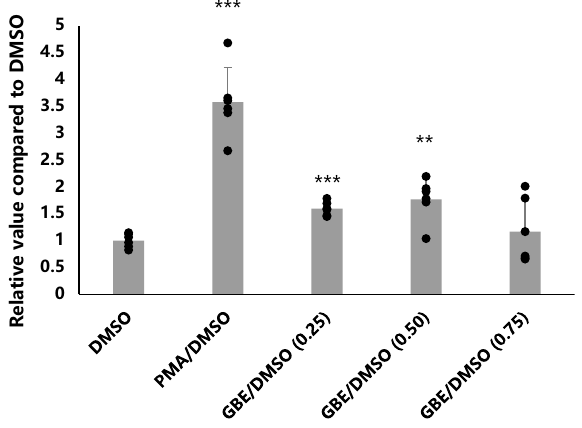
Figure 1. Effects of various GBEs concentrations on EGR-1 activation in a luciferase assay. GBEs were tested at three different doses, and both 0.25 mg/ml and 0.5 mg/ml concentrations of GBEs showed a statistically significant increase in EGR-1 activity in a luciferase assay (n = 6). ** p < 0.01, *** p < 0.001. Bars represent mean + / − standard deviations. The one-way ANOVA was used for statistical analysis. EGR-1: early growth response protein 1; GBEs: Ginkgo biloba Extracts; DMSO: dimethyl sulfoxide; PMA: phorbol 12-myristate